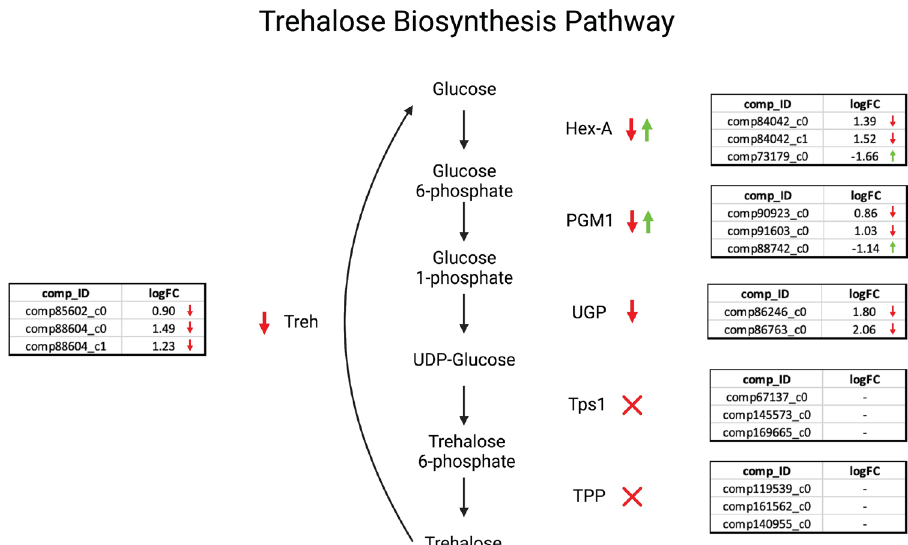
Fig. 2 Reciprocal best BLAST analysis results for trehalose pathway components in H. exemplaris . Orthologs of tardigrade biosynthesis genes identi fi ed through reciprocal best BLAST analysis mapped to differential gene expression. Comp_IDs indicate transcript accession numbers. LogFC indicates the log2 fold change values for each transcript in a hydrated state relative to the desiccated state (such that a negative number indicates a higher enrichment in the dry